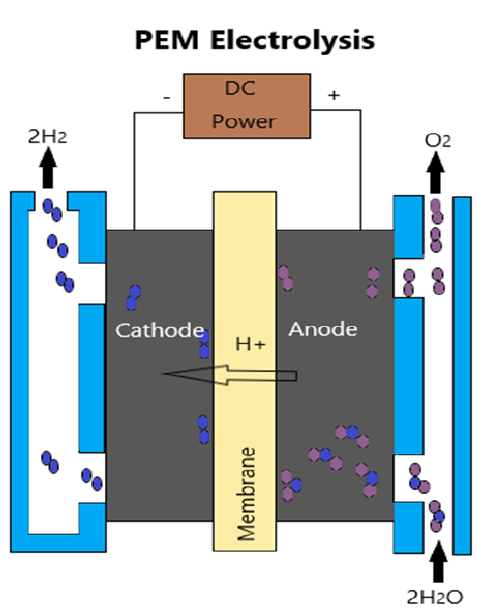
Figure 1. Schematic of the PEM electrolyzer cell.